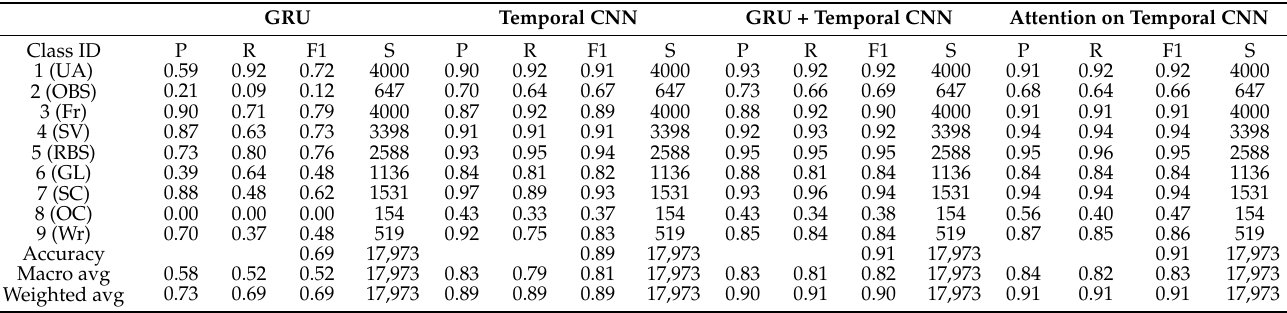
classification results using existing and proposed models. The LCC classification results are of temporal and spatiotemporal models. Tables 2 and 3 shows the per-class accuracy, overall accuracy, per class F1 score, macro average, and weighted average F1 score for the eight deep learning models. Table 2. Precision, recall, and F1 score values for the GRU, temporal CNN and attention models on temporal CNN.